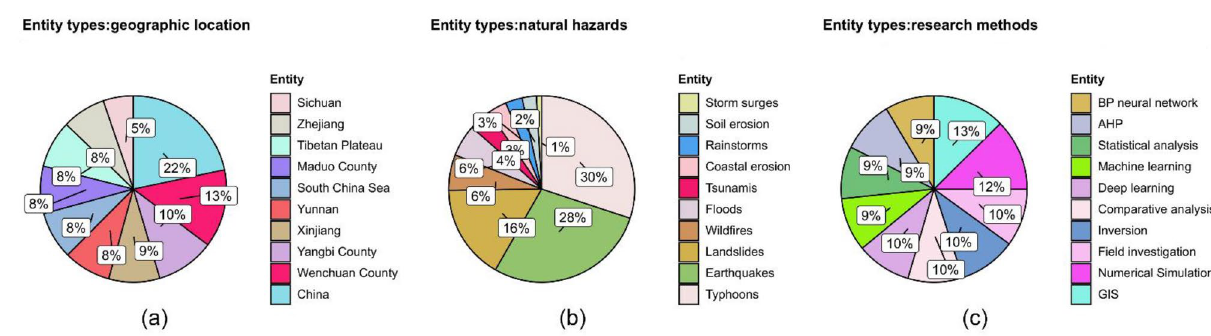
Figure 7. Proportion charts of the three types of entities: ( a ) Proportion of geographical location, ( b ) Proportion of natural hazards, ( c ) Proportion of research